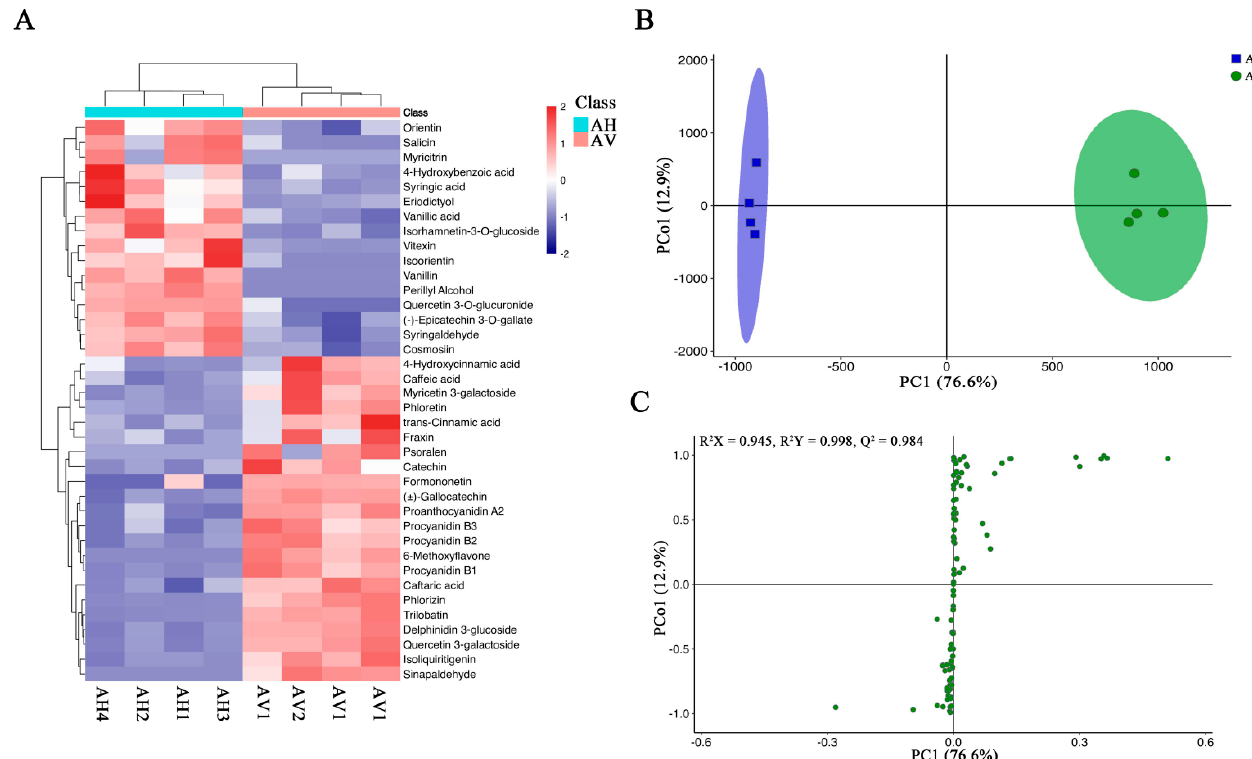
Figure 3. Heat map of the various flavonoid components and differential flavonoid metabolite analysis based on OPLS-DA. ( A ) a heat map of the various flavonoid components. ( B , C ) OPLS-DA differential metabolite analysis plots. AV means A. venetum , AH A. hendersonii, and the numbers 1, 2, 3, and 4 (as in AV1, AH1) stand for replicates numbers .